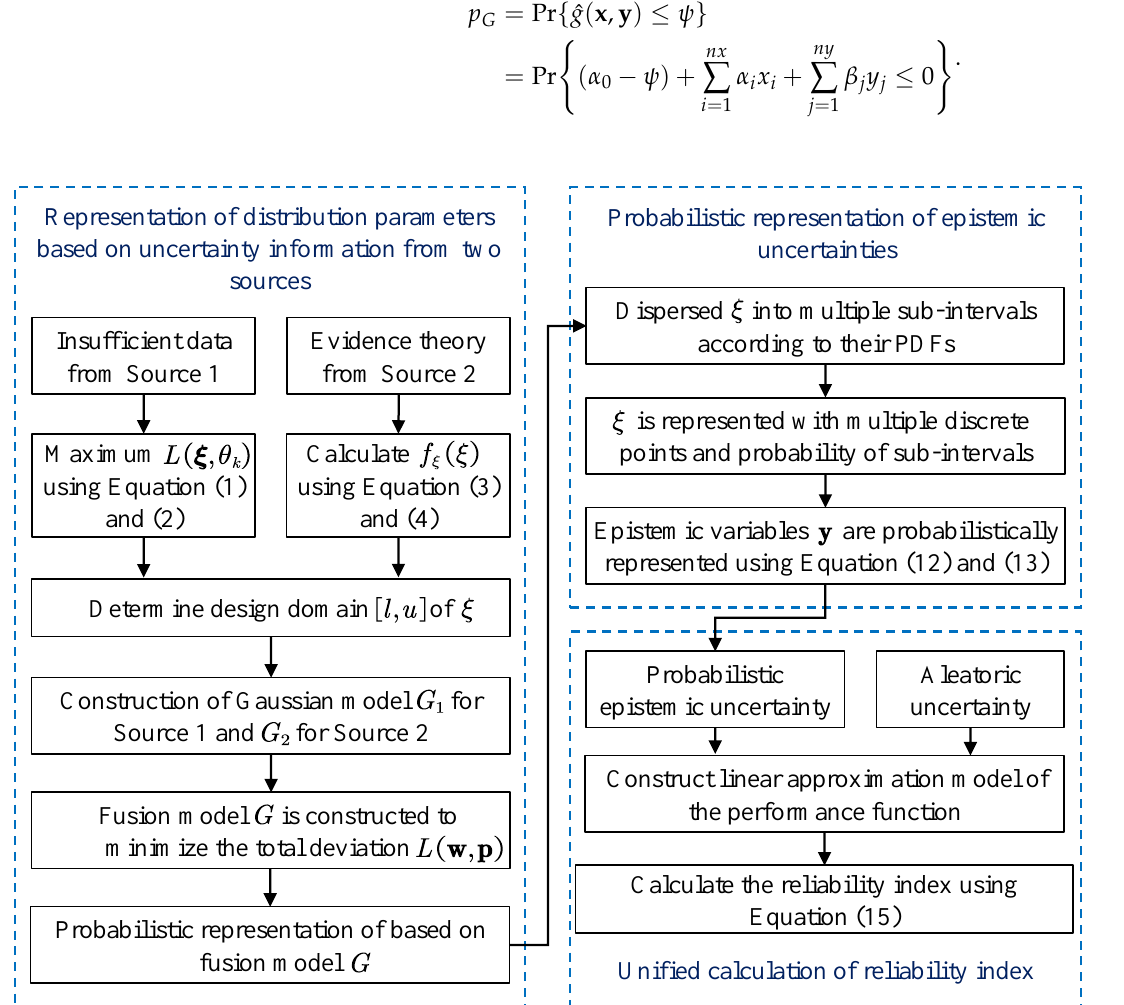
Figure 1. The solution flowchart of the proposed